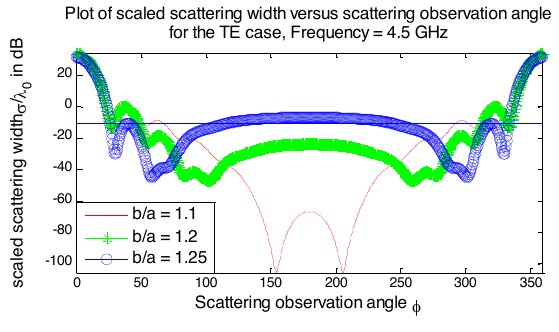
FIGURE 10. Normalized backscattering width (TM polarization) versus frequency of Rings and rods media coating with c/a = 1.3